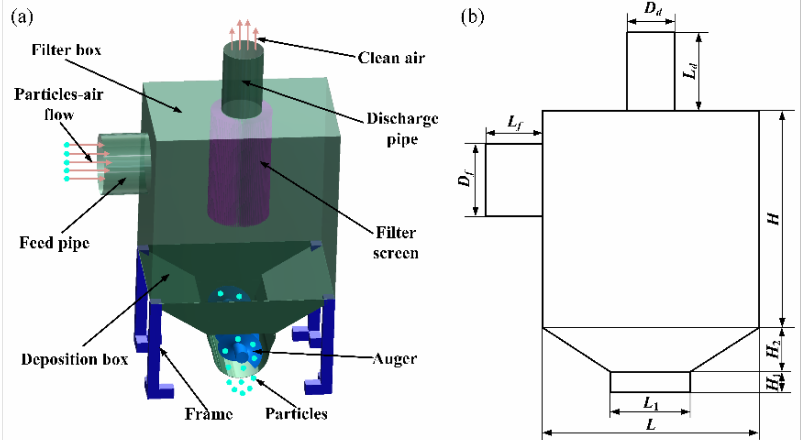
Figure 1. Overall structure configuration of filter equipment. ( a ) overall structure configuration ( b ) device size